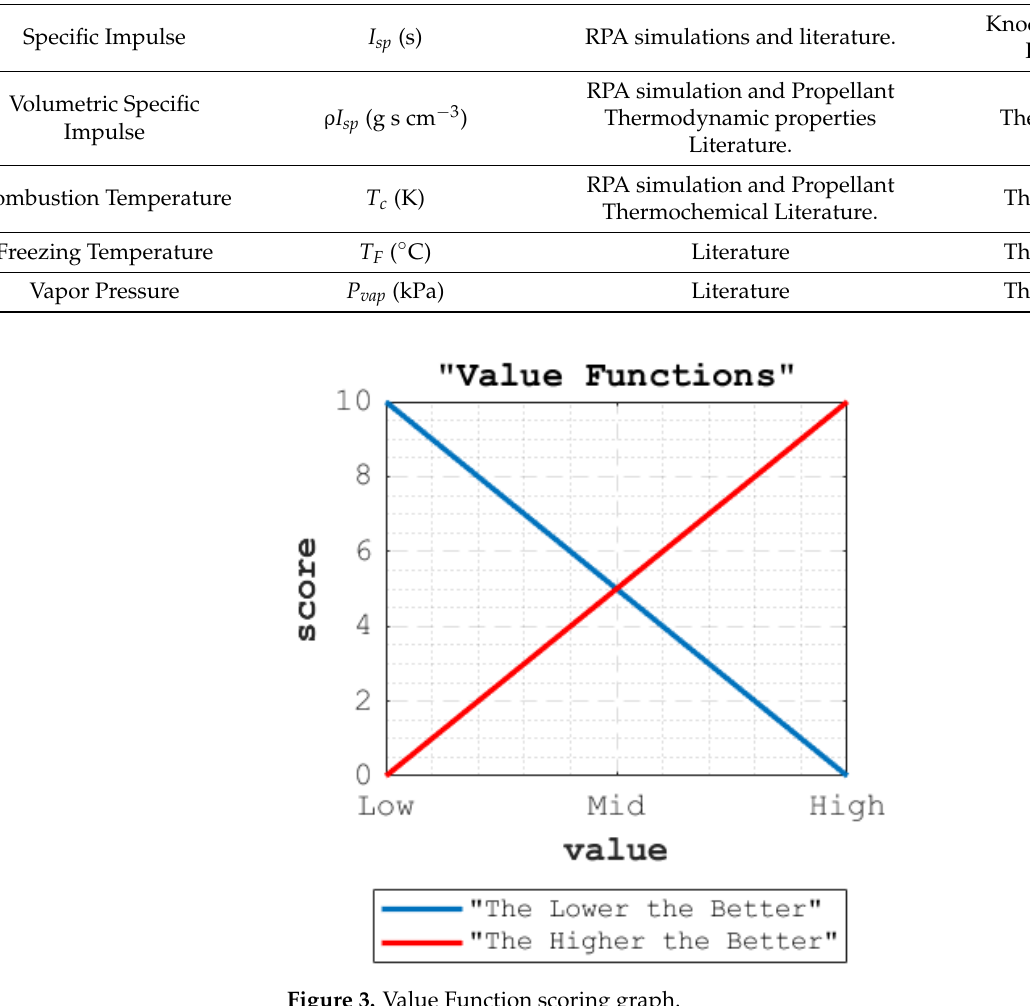
Figure 3. Value Function scoring graph.